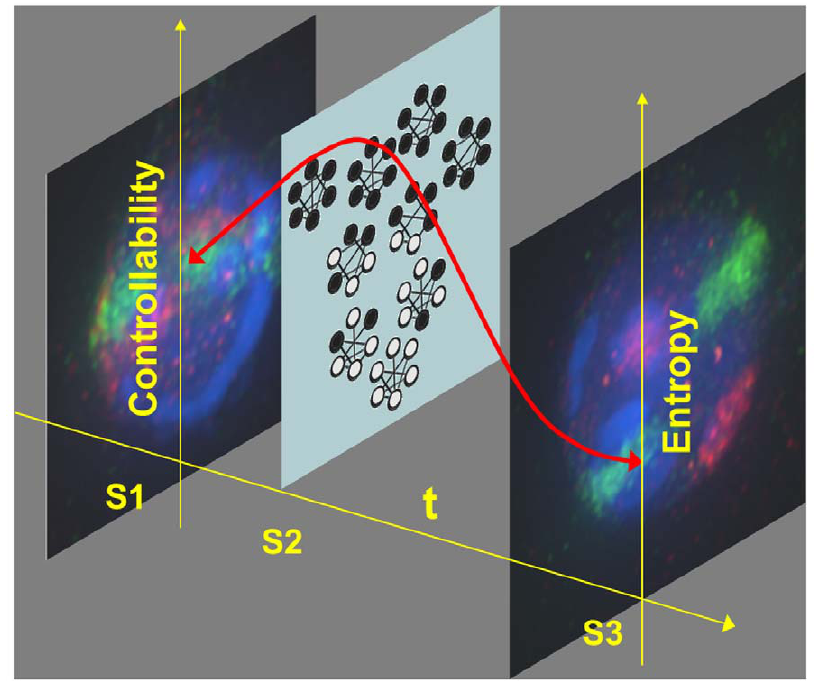
Figure 1. Dynamics of network controllability and entropy. The process of cell differentiation as a dynamical system varies in degree of controllability, or receptivity to external signals at particular stages, where cells pass through an intermediate highly receptive and entropic state. S1 (state 1, stem/progenitor state), S2 (state 2, transition state), S3 (state 3, terminally differentiated state).